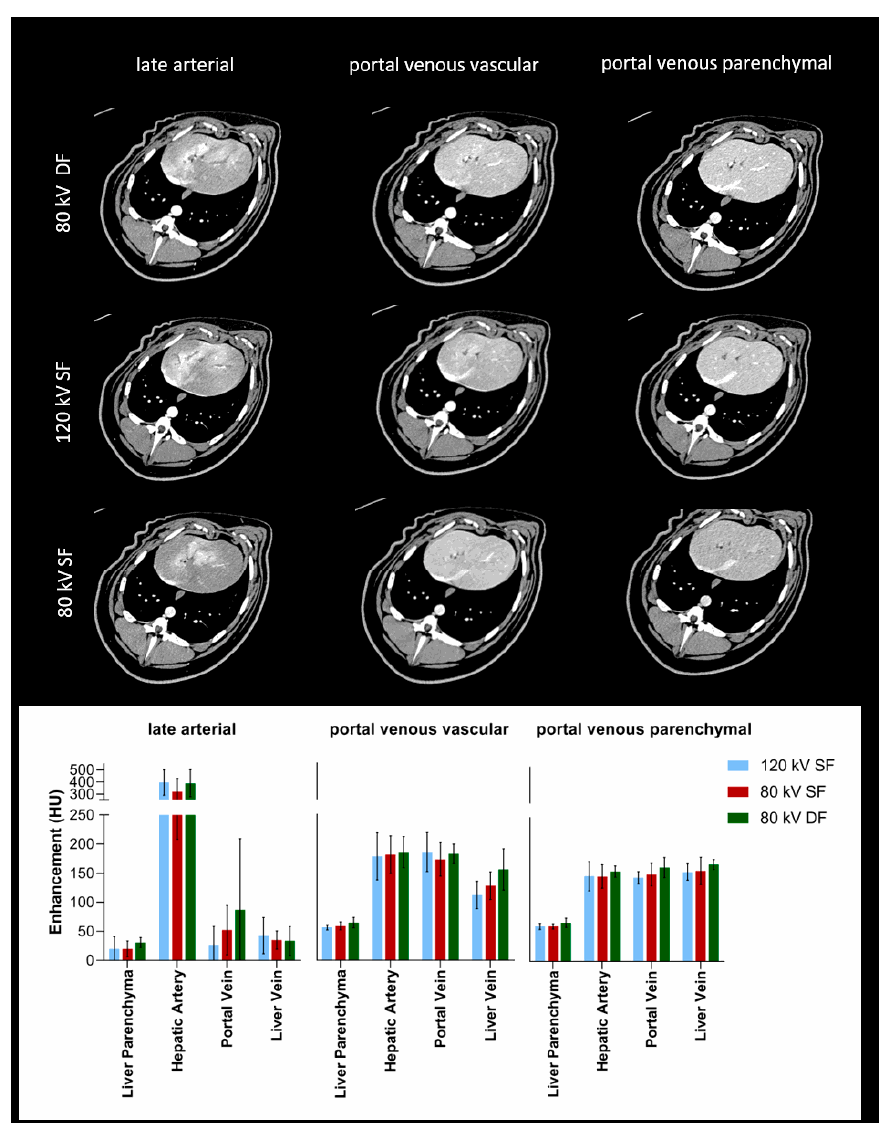
Figure 4. Enhancement of hepatic structures. Columns show the enhancement of clinically relevant structures of the liver for the different injection protocols and clinically relevant phases. Table 3. Hepatic peak attenuation.